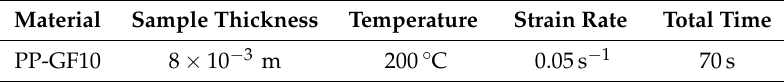
Table 3. Process settings of the constant planar extensional flow experiment in [18]. Material